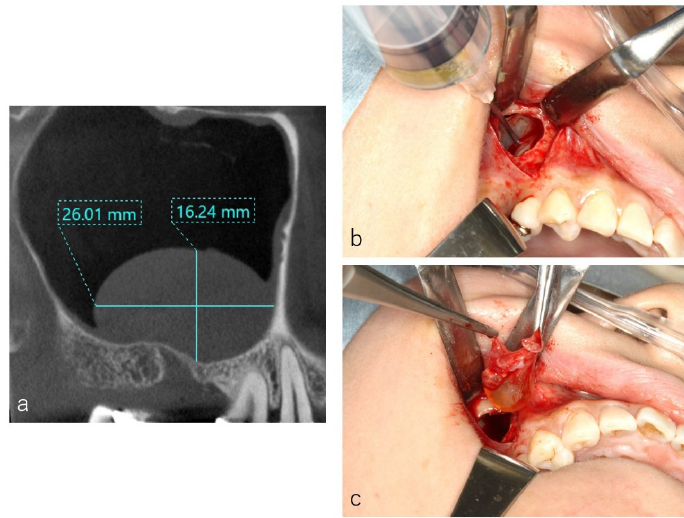
Figure 5. Case: 44 years old female. As the medio-distal size was 26.0 mm ( a ), the preliminary suction of the contents of cystic lesion was performed with a fine 18-gauge needle ( b ). The wall of the cystic lesion was clamped with forceps and herniated through the window with gentle outward traction ( c ). After confirmation by the endoscope of the hemostasis (Figure 2c), the antrostomy was covered with a resorbable collagen membrane to reduce blood inflow to the sinus cavity, and the mucoperiosteal flap was closed. As an antibiotic, Azithromycin hydrate (500 mg) was taken 1 h before the surgery and once a day following two days. Loxoprofen sodium hydrate (60 mg) were prescribed for single use as a pain killer.